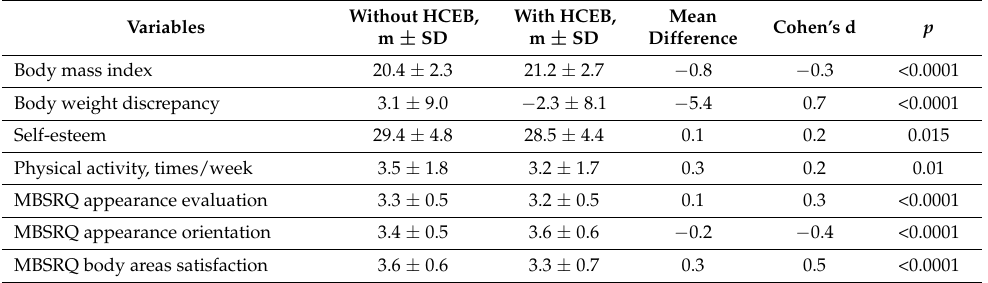
Table 3. Associations between adolescents’ health compromising eating behaviours and study